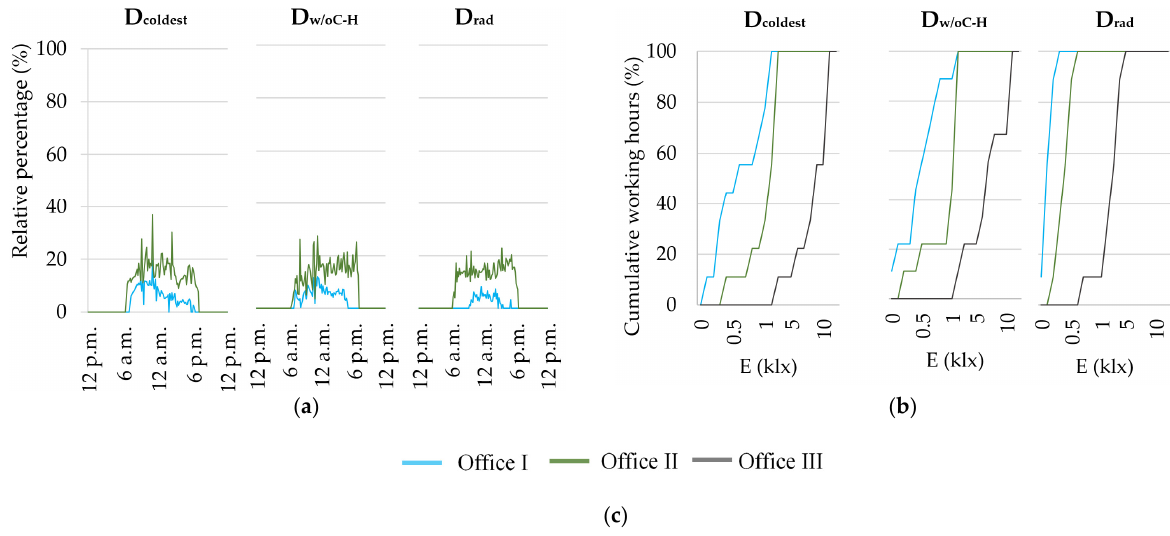
Figure 10. Indoor illuminance levels on the vertical plane in the office rooms for the heating period representative days: ( a ) relative percentage (%) compared with the reference office room III without SCF; ( b ) cumulative frequency of working hours (9 a.m. to 6 p.m.) with less than certain levels of indoor illuminance, in %.; ( c )